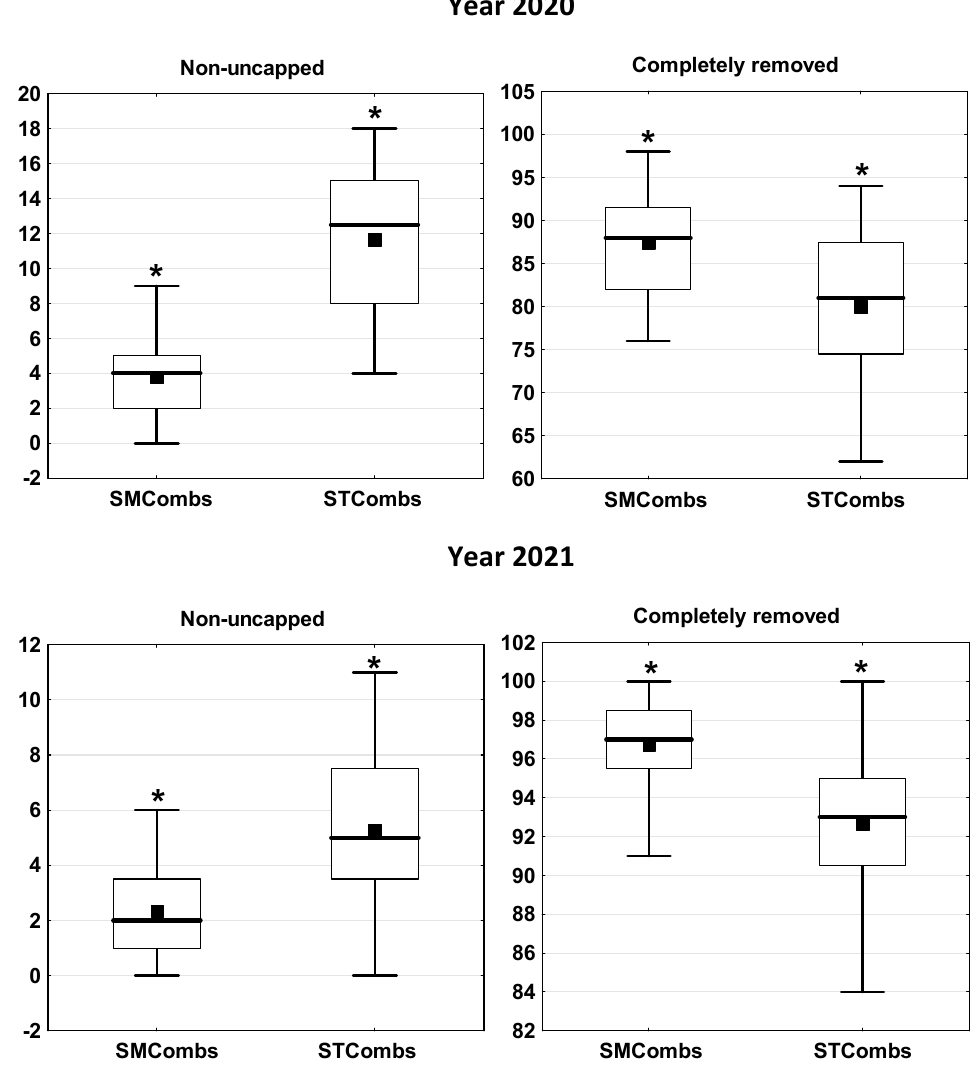
Figure 2. Years 2020 and 2021; number of cells with pierced brood, non-uncapped and completely removed in small-cell and standard-cell combs. SMCombs—small-cell combs; STCombs—standard- cell combs; the boxes indicate the data between the 25 and 75% quartiles including the median (black line); the black squares represent the mean; the whiskers represent the minimum and maximum values; *—the difference between SMCombs and STCombs is significant at p ≤ 0.01; (pairwise Wilcoxon